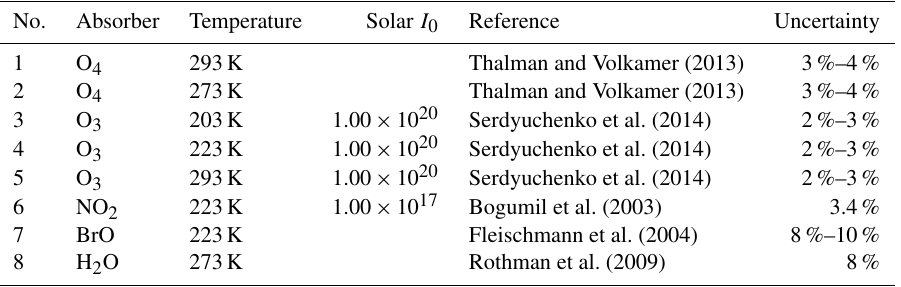
Table 2. Spectral retrieval absorption cross sections used for the DOAS method analysis (Hüneke et al., 2017; Stutz et al., 2017). The solar I 0 correction used is suggested in Aliwell et al.